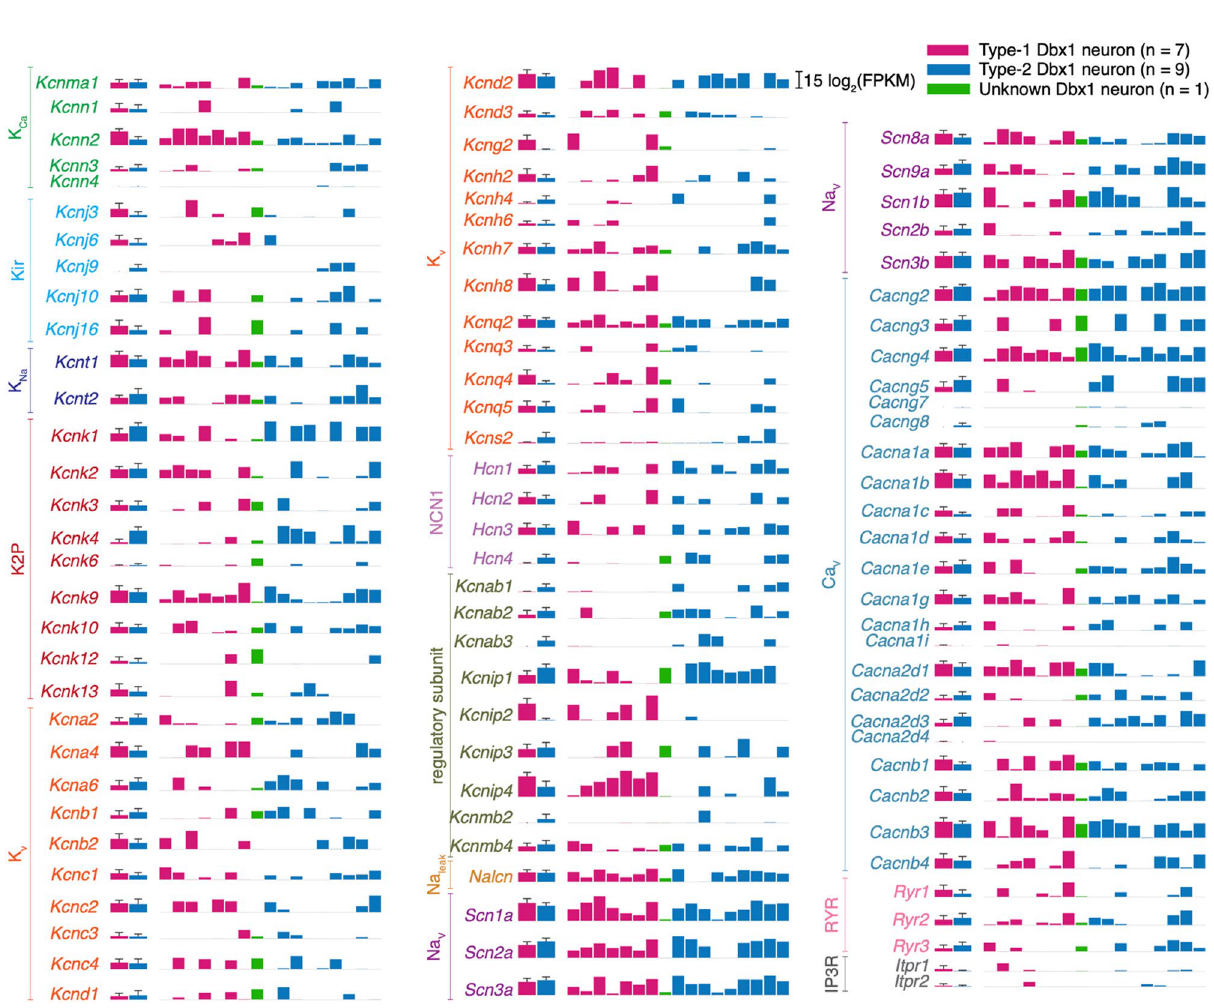
Figure 5. Quantitative gene expression for voltage-dependent ion channels, regulatory subunits, and intracellular receptors. The first two bars show group data for Type-1 (n = 7; magenta bar) and Type-2 (n = 9; blue-cyan bar). The height of the bar is log 2 (mean FPKM) value and the error bar with horizontal cap shows log 2 (mean + SD). The next of 17 bars shows log 2 (FPKM) values for each neuron in the following order: 7 Type-1 neurons (magenta), 1 Unknown neuron (green), and 9 Type-2 neurons (blue-cyan). Gene names are color- coded according to the subfamily to which they belong. None are